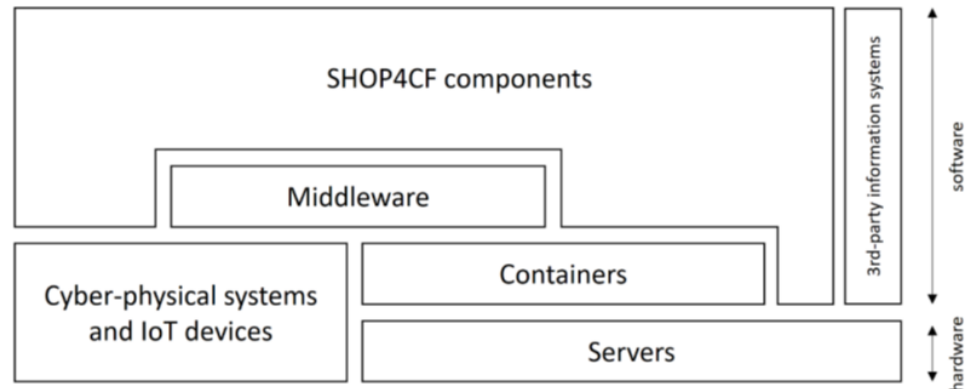
Figure 1. Top-level logical platform architecture of the SHOP4CF project [20].